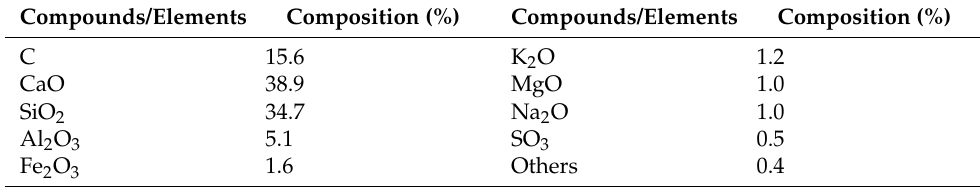
Table 1. XRF analysis of BBCEC. Compounds/Elements Composition (%) Compounds/Elements Composition (%)